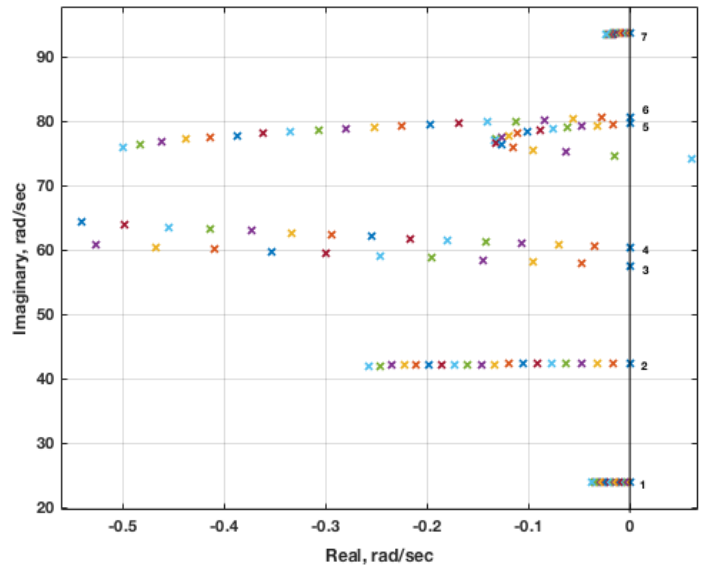
Figure 13. Root locus plot generated from ROM model indicating an aeroelastic instability at M = 0.90 in air test medium for the third configuration with each colored marker indicating an increment of 450 N/m 2 in dynamic pressure for a given